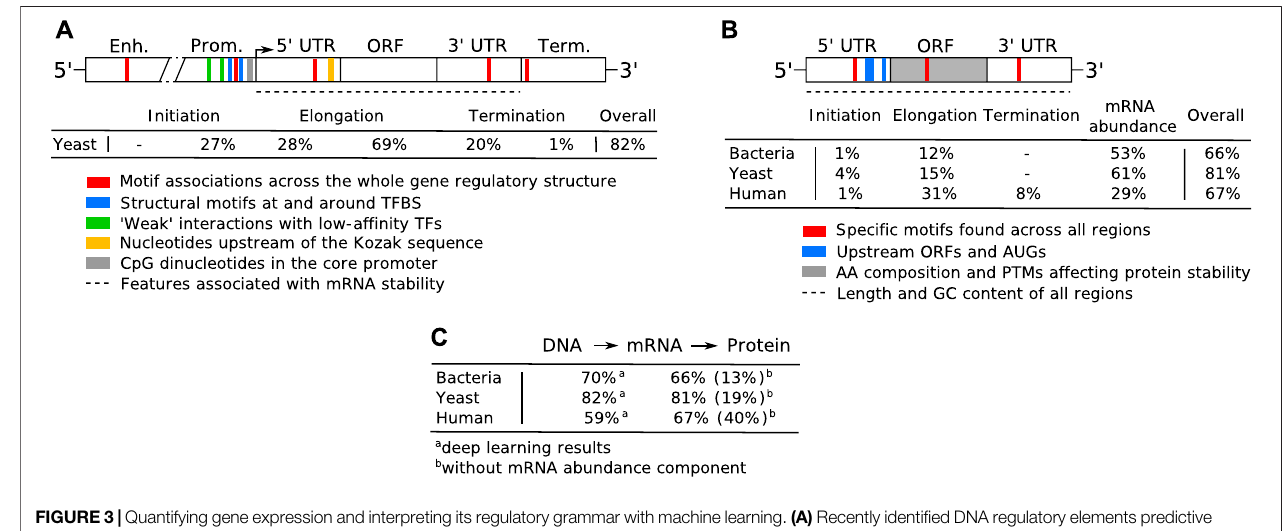
FIGURE3 | Quantifying gene expression and interpretingits regulatory grammar with machine learning. (A) Recently identi fi ed DNA regulatory elements predictive of mRNA abundance that expand the base knowledge depicted in Figure 1B . These include motif associations (Zrimec et al., 2020) (red), structural motifs (e.g. DNA shape,blue)(Zhouetal.,2015;Yangetal.,2017),weakinteractions(deBoeretal.,2020)(green),nucleotidesupstreamoftheKozaksequence(Lietal.,2017a)(yellow), CpG dinucleotides (Agarwal and Shendure, 2020) (gray) and mRNA stability features (Neymotin et al., 2016; Cheng et al., 2017; Agarwal and Shendure, 2020; Zrimecetal.,2020)(dashedline,seetextfordetails)identi fi edinspeci fi cregionsoracrossthewholegeneregulatorystructure.Thetable speci fi esthevariationofmRNA abundance explained by DNA sequence and features using deep learning (Zrimec et al., 2020). Note that with alternative approaches, higher predictive values were obtained for certain regions in Table 2 . (B) mRNA regulatory elements recently found to be predictive of protein abundance apart from features depicted in Figure 1C . These include speci fi c motifs found across all regions (Li et al., 2019a; Eraslan et al., 2019b) (red), upstream ORFs (Vogel et al., 2010; Li et al., 2019a) and AUGs (Neymotin et al., 2016; Li et al., 2019a) (blue), AA composition (Vogel et al., 2010; Guimaraes et al., 2014) and post-translational modi fi cations (PTMs) (Eraslan et al., 2019b)(gray)aswellaslengthsand GCcontent ofallregions(Neymotinet al.,2016;Chenget al.,2017;Liet al.,2019a)(dashedline). Thetable speci fi esthevariationof proteinabundanceexplainedbymRNAlevelsandtranslationalelements,usingcomparableshallowapproachesin E.coli (Guimaraesetal.,2014), S.cerevisiae